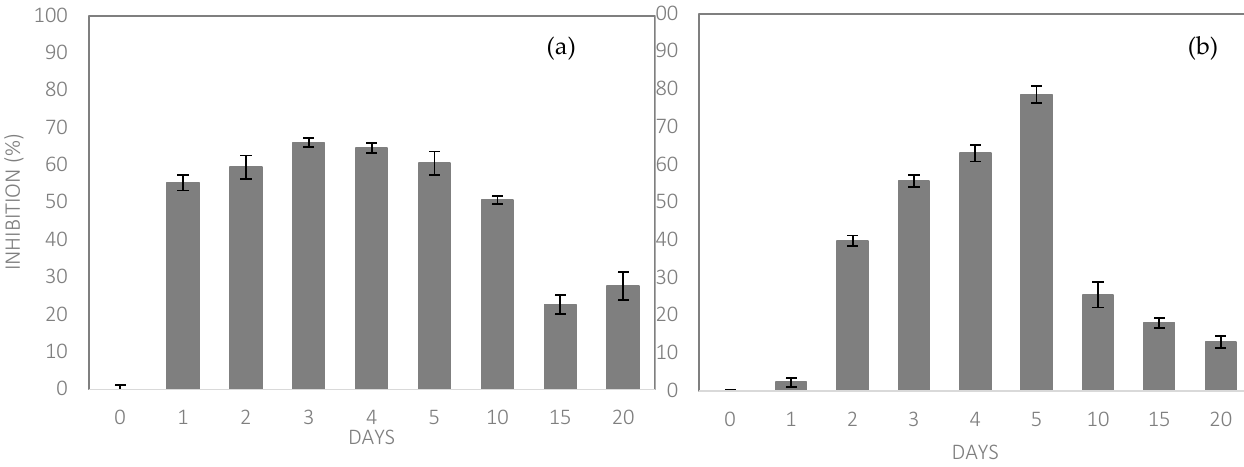
Figure 7. Bacteriocin release incorporated in the polymeric matrix. ( a ) Inhibition under Escherichia coli . ( b ) Inhibition under Staphylococcus